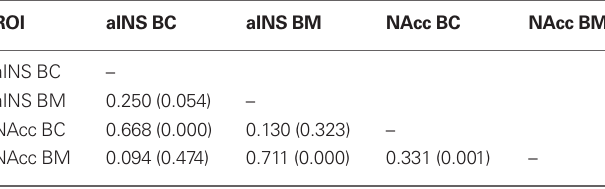
Table 1 | Correlations between aINS and NAcc activation in different conditions.